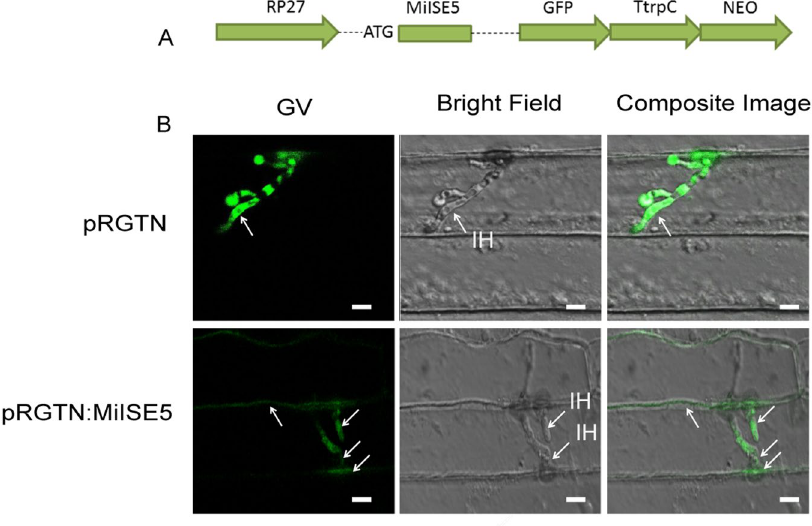
Figure 4. MiISE5 can be secreted through M. oryzae infectious hyphae to plant cells. ( A ) Diagrams of the GFP fusion constructs. The MiISE5-GFP fusion construct pRGTN:MiISE5 was under the control of the RP27 promoter. ( B ) GFP signals (white arrows) can be observed in the infectious hyphae and plant cells of the M. oryzae transformed with empty vector (pRGTN) and pRGTN:MiISE5, but the GFP signals can only be observed in plant cells penetrated by the infectious hyphae of pRGTN:MiISE5 transformed strain. IH: infectious hyphae. Scale bar = 10 μ m.